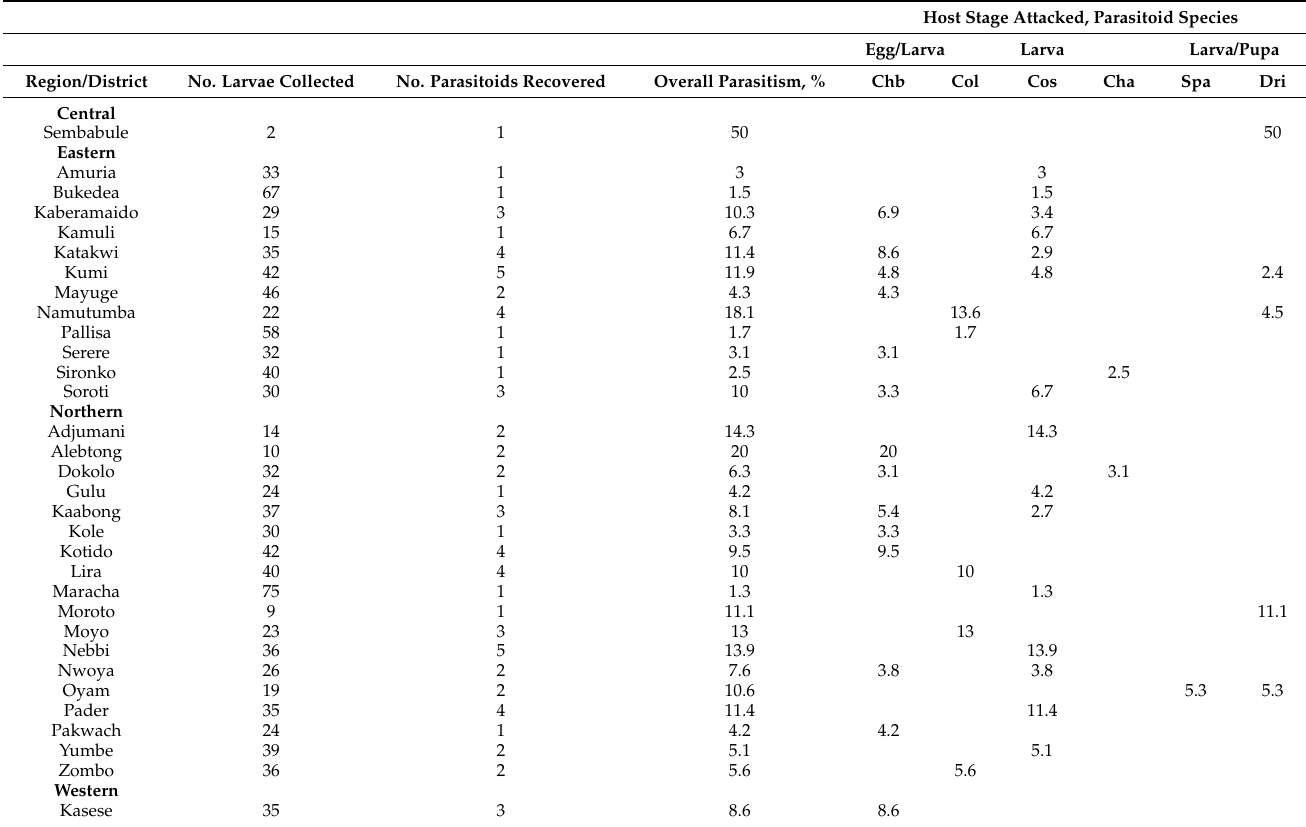
Table 3. Total larvae and parasitism of Spodoptera frugiperda larvae collected from different districts of Uganda in 2017. No. par = total parasitoids recovered; Para = % parasitism; Chb = Chelonus bifoveolatus ; Col = Coccygidium luteum ; Cos = Coccygidium sp; Chd = Charops cf. diversipes ; Spa = Sturmiopsis parasitica ; Dri = Drino quadrizonula. Host Stage Attacked, Parasitoid Species Egg/Larva Larva Larva/Pupa Region/District No. Parasitoids Recovered Overall Parasitism,